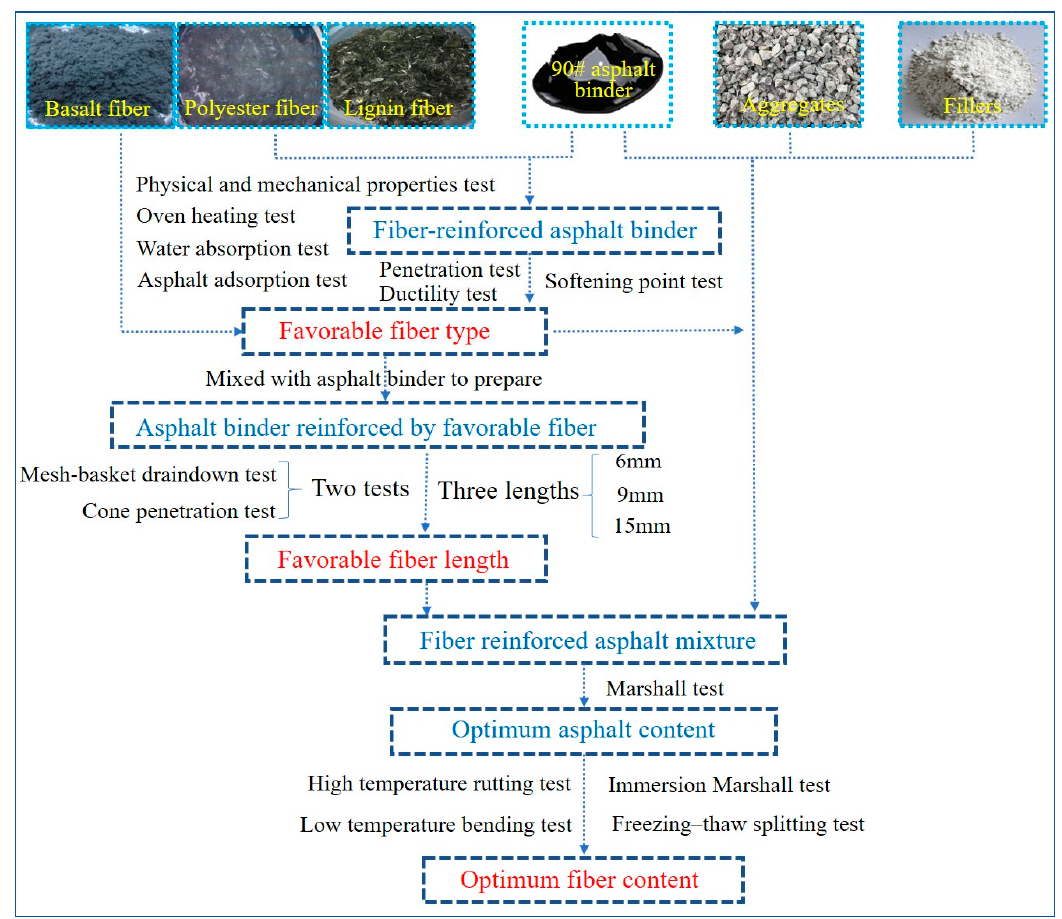
Figure 3. Flow chart of testing methods.